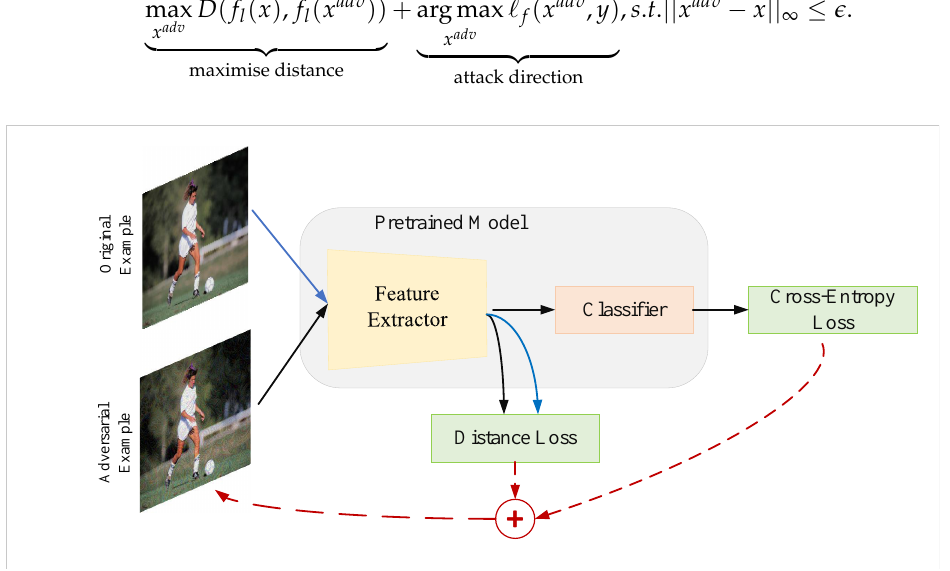
Figure 3. Illustration of the distance metric attack